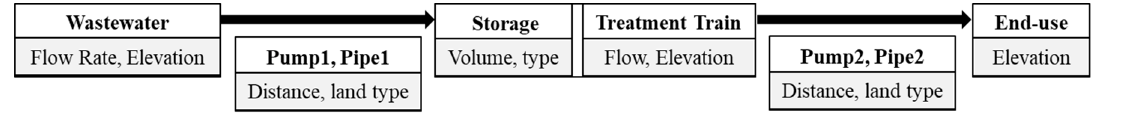
Figure 3. Schematic representation for the distribution components and information required for the cost calculation (grey).